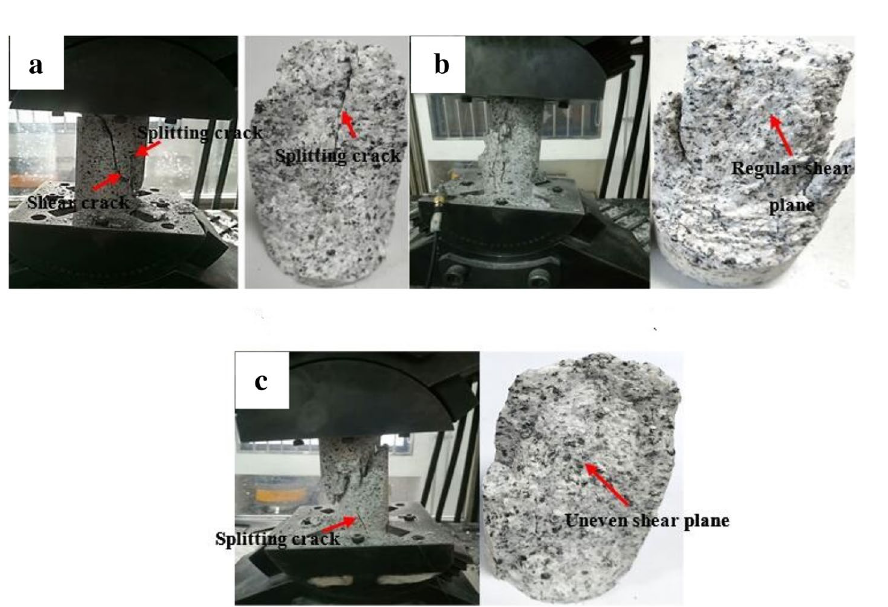
Figure 3. Granite specimen failure patterns at an inclination angle of 5°: ( a ) Experimental case 2–1; ( b ) experimental case 2–2; and ( c ) experimental case